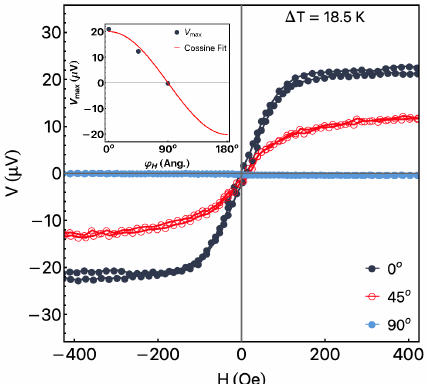
Figure 5. Angular dependence of the V max as a function of H for the AR ribbon measured at ∆ T = 18.5 K. The inset shows V max as a function of the ϕ H values. The red solid line is a fit of the experimental data using a cosine